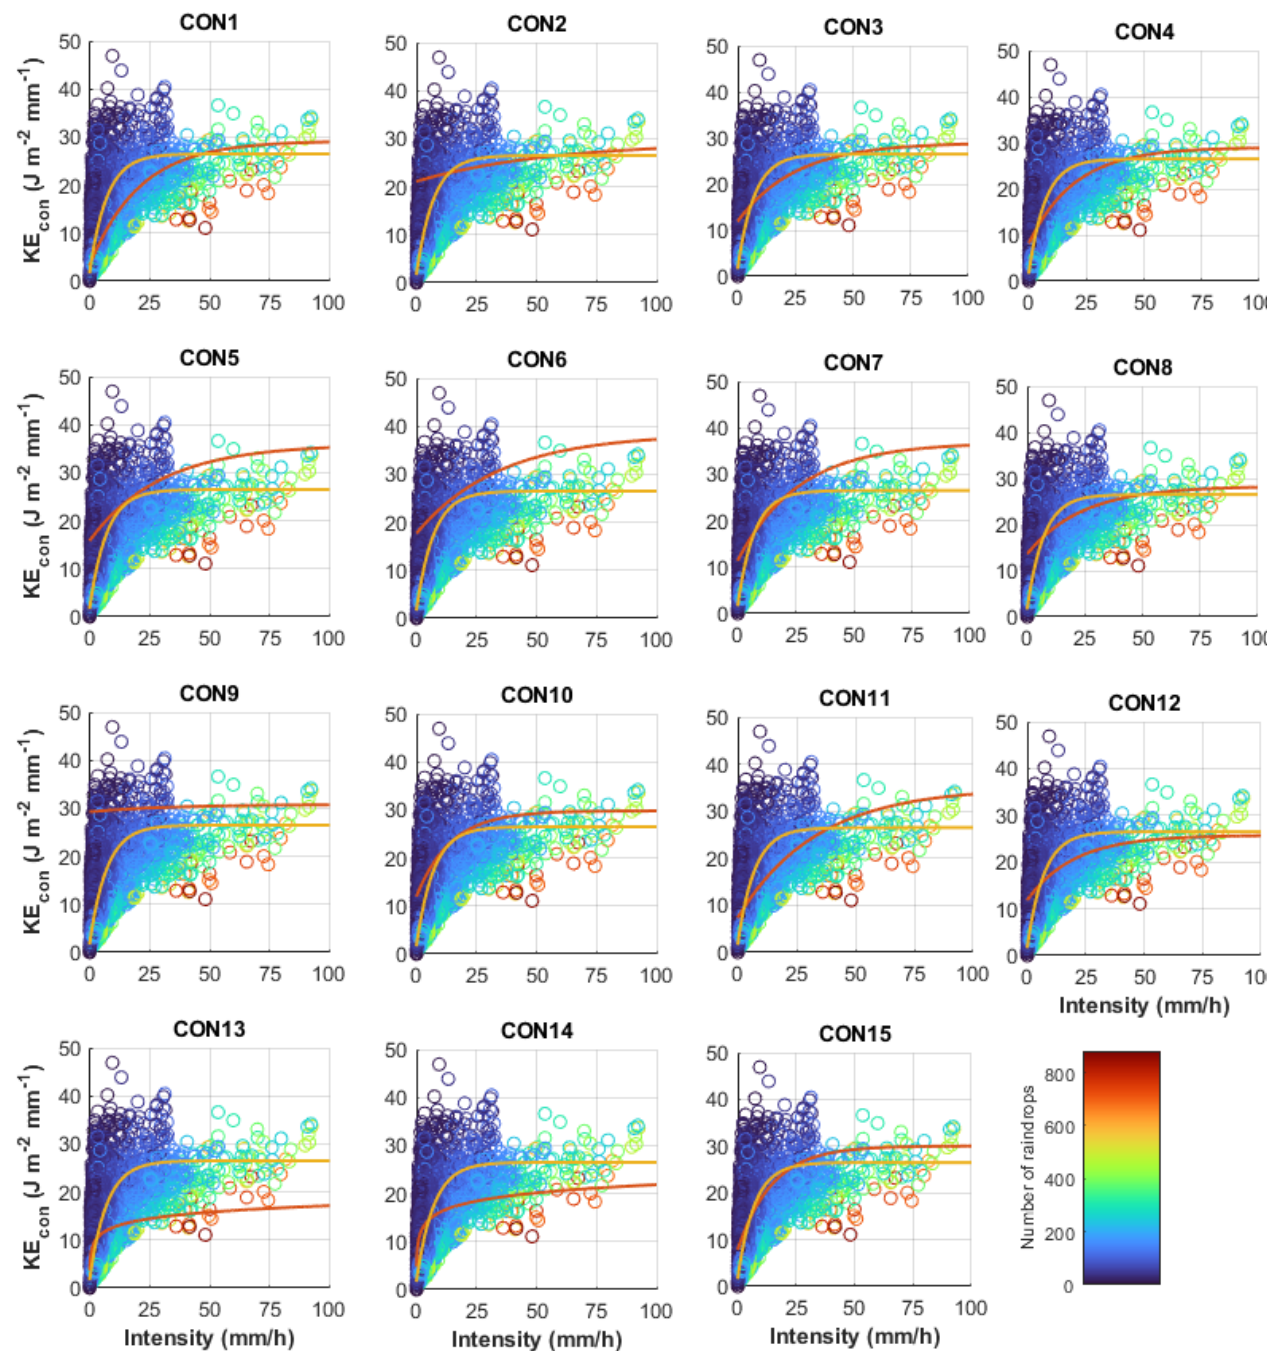
Figure 7. Comparison of 15 KE con equations (represented by red lines) with measured data. The yellow line represents the fitted line of measured data (CON16).